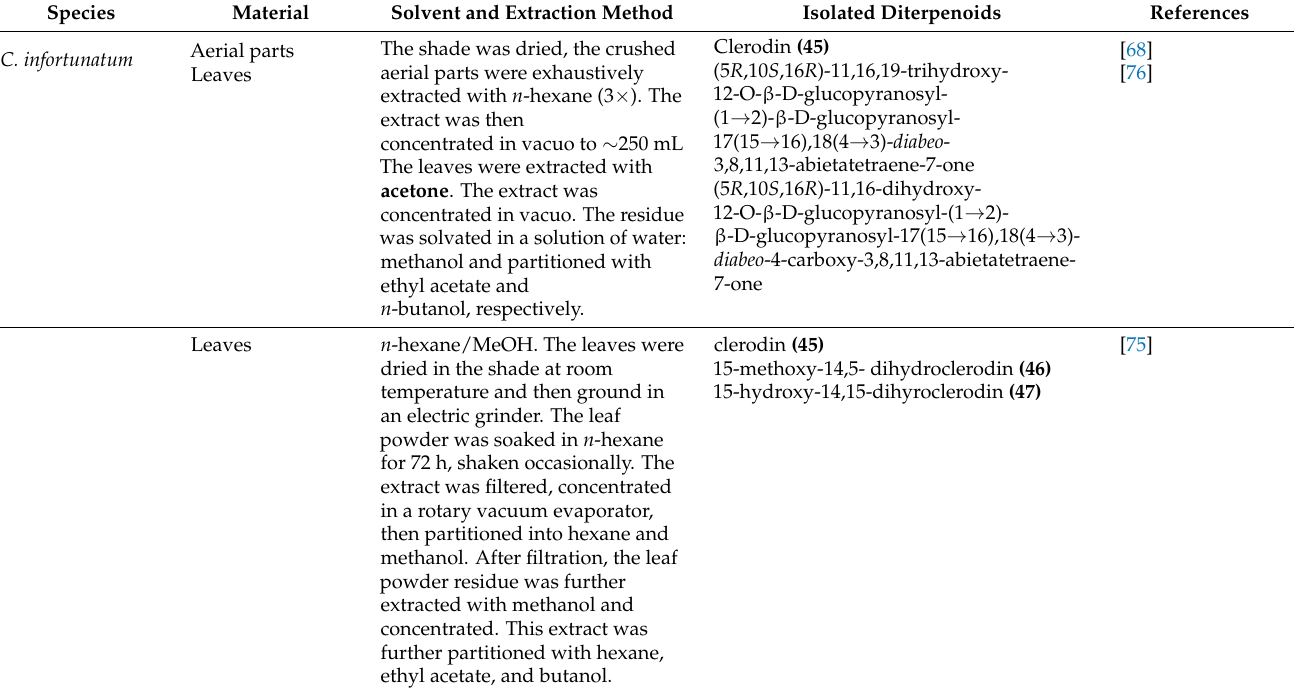
Table 6. The diterpenoid extraction methods and C. infortunatum plant materials for diterpenoid